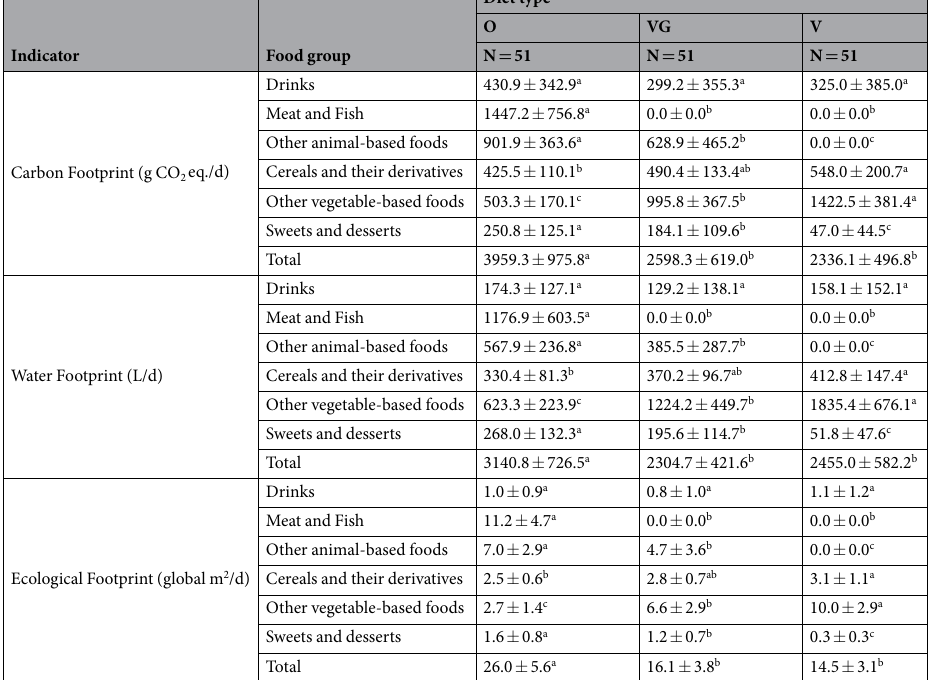
Ecological Footprint (global m 2 /d)